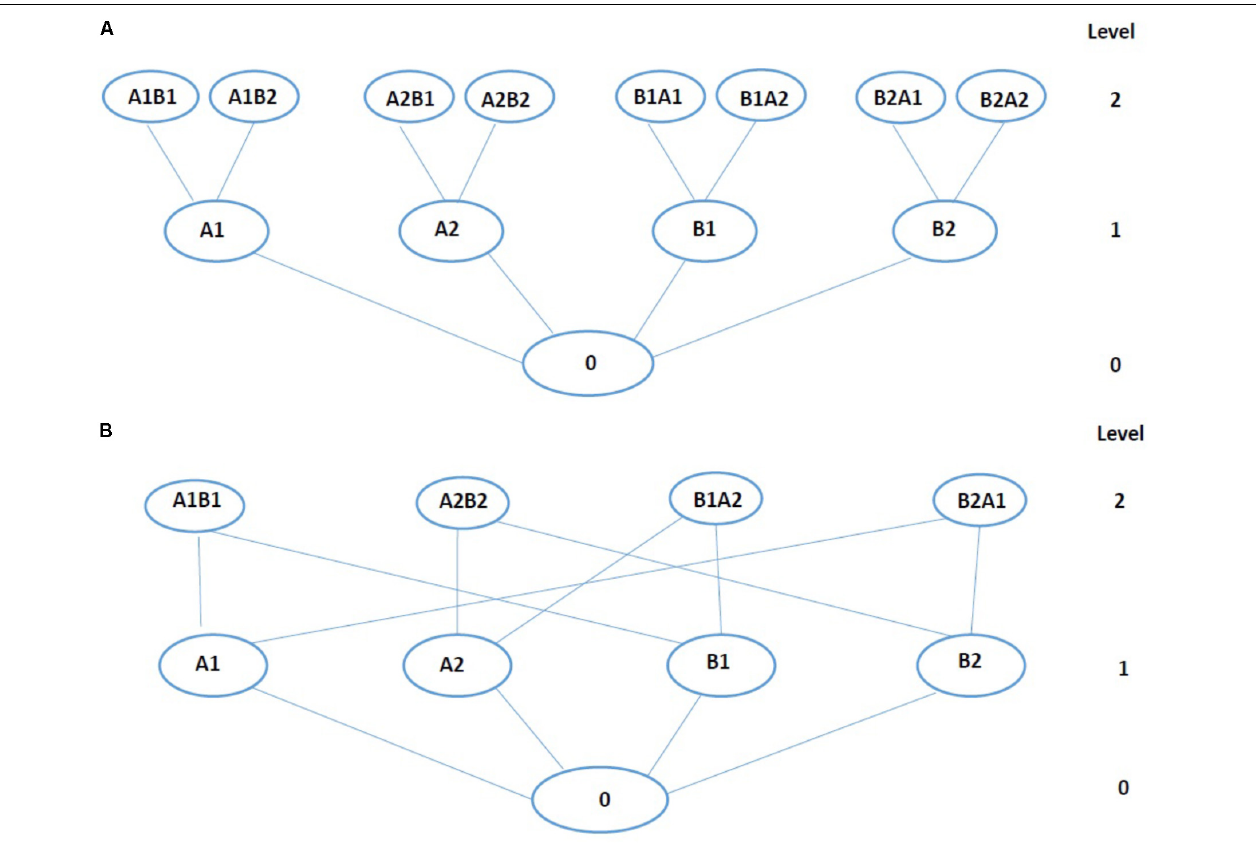
FIGURE 2 | Tree representation of the data. (A) The tree with sequential structure. (B) The tree with trellis-like structure (alternative version of the A ). Each circle stands for single drug-dose or combination. Letter and number indicates drug and dose, respectively. For a tree, level 0 is the control (no drug), level 1 is composed of individual drug treatment with two doses, and level 2 is composed of drug-dose combinations. The level depends on the size of the